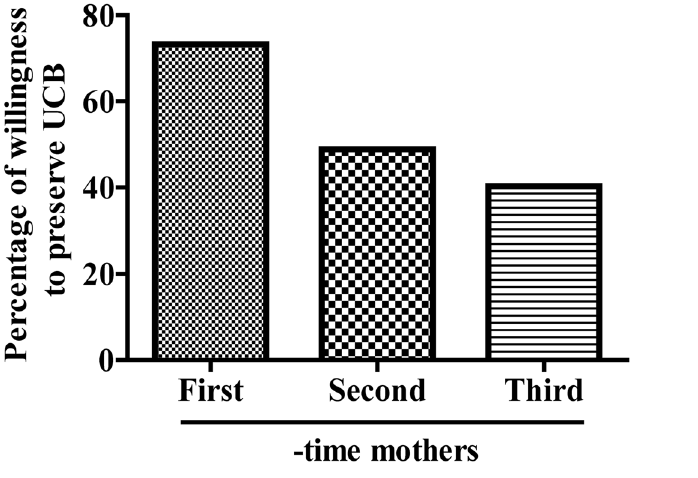
Fig 1. Effect of number of children on willingness to preserve UCB.